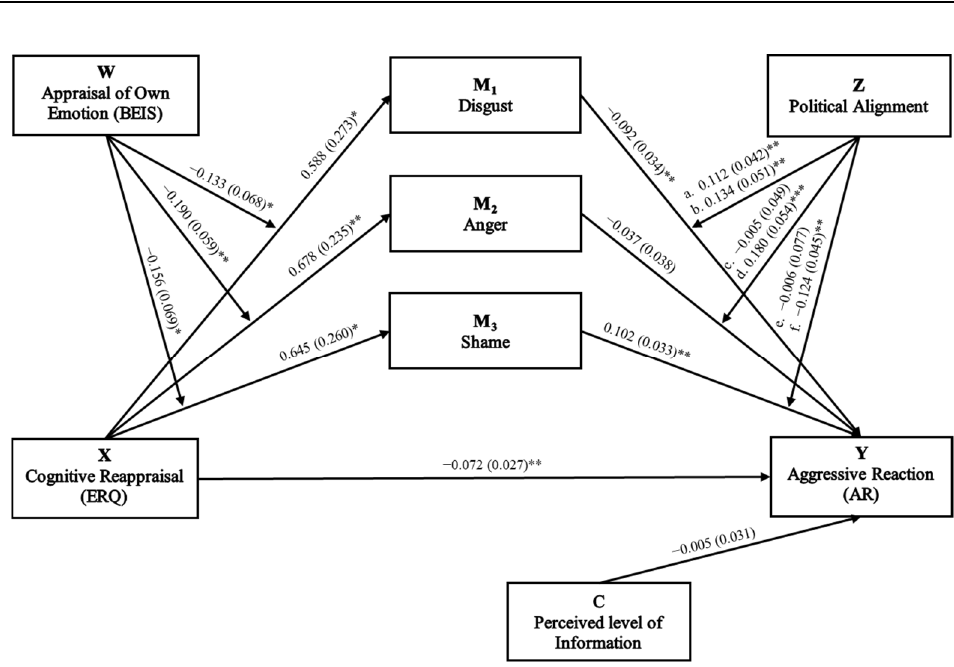
Figure 2. Multiple moderated mediation model in which the mediators were considered in parallel. Numbers represent standardised coefficients. Numbers within parentheses represent standardised errors. Note: X, independent variable; Y, dependent variable; C, covariate; M1, mediator 1; M2, mediator 2; M3, Mediator 3; W, Moderator 1; Z, Moderator 2; a., M1 × Z1; b., M1 × Z2; c., M2 × Z1; d., M2 × Z2; e., M3 × Z1; f., M3 × Z2; * p < 0.05; ** p < 0.01; *** p < 0.001.